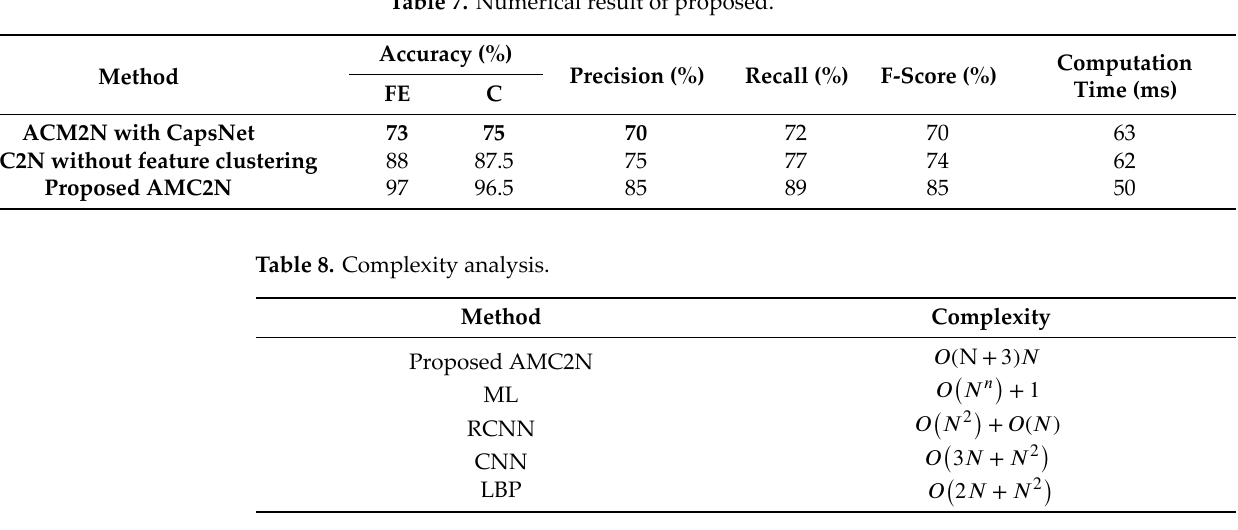
Table 7. Numerical result of proposed.